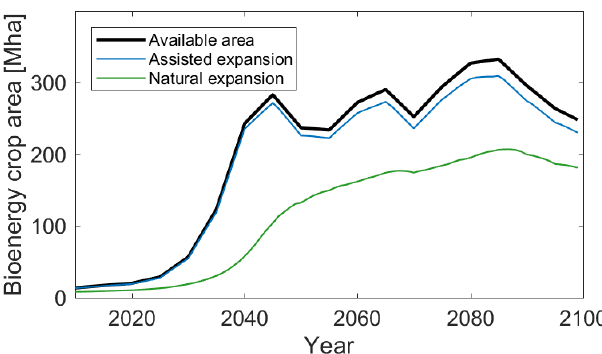
Figure 7. Modelled area of Miscanthus under RCP2.6-SSP2, show- ing the effect of the agricultural expansion functionality. “Assisted expansion” shows the model run using the assisted expansion func- tion, compared to “Natural expansion” in which this function is dis- abled. “Available area” shows the total available area for bioenergy crops under this scenario.